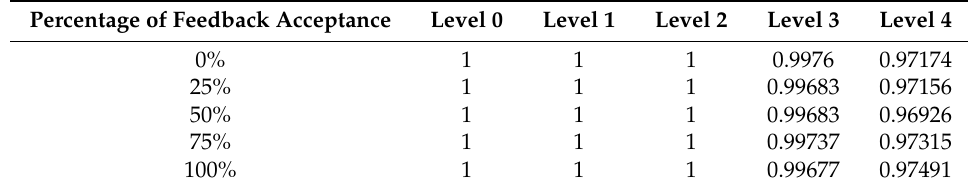
Table 6. User trust levels concerning autonomy when the devices’ error increases with the task level and the user is open-minded.